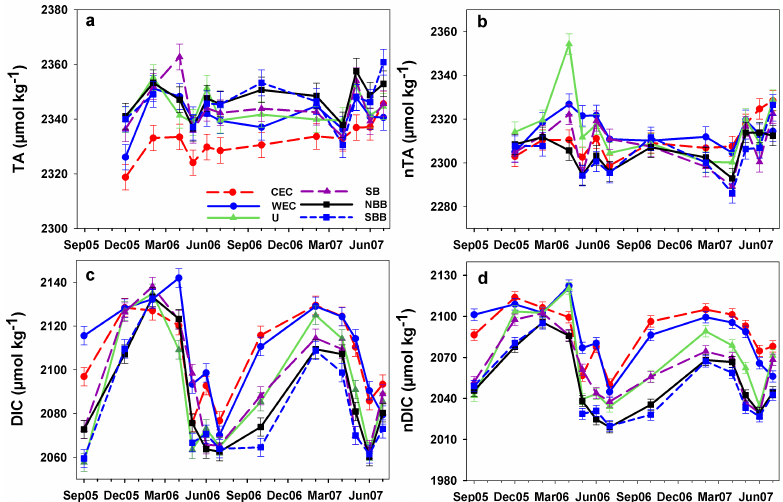
Fig. 4. Monthly mean concentrations (µmolkg − 1 ) of (a) TA, (b) nTA, (c) DIC and (d) nDIC: Central English Channel (dashed red line; circles); Western English Channel (blue line; circles); Ushant (green line; triangles); Shelf Break (dashed purple line; triangles); Northern Bay of Biscay (black line; squares); Southern Bay of Biscay (short dashed blue line; squares). Each data point represents the average of several measurements made within one part of the transect (Fig. 1). The error bars represent the standard deviation of each mean. Data points are linearly interpolated between sampling points to allow a clear distinction of observations between regions. It should not be assumed that the interpolation provides an accurate estimate of the missing